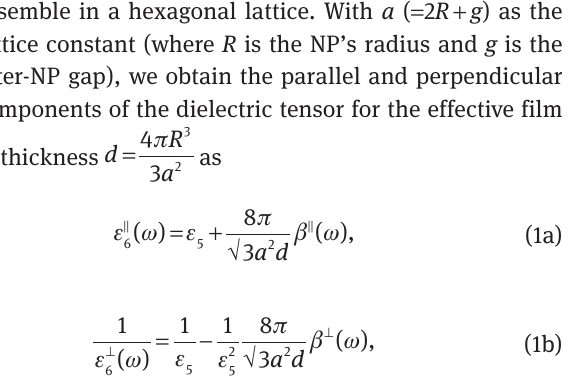
Figure 2: (A) Schematic of the proposed Fabry–Perot interferometer cavity and (B) its equivalent theoretical nine- layer-stack model. Parameters: R , radius of the NPs; g , inter-NP separation; h , thickness of the spacer layer; h , thickness of s f the metallic film electrodes; L , cavity length; d , thickness of the effective film emulating an NP monolayer; and k , the wave vector of light incident at angle θ